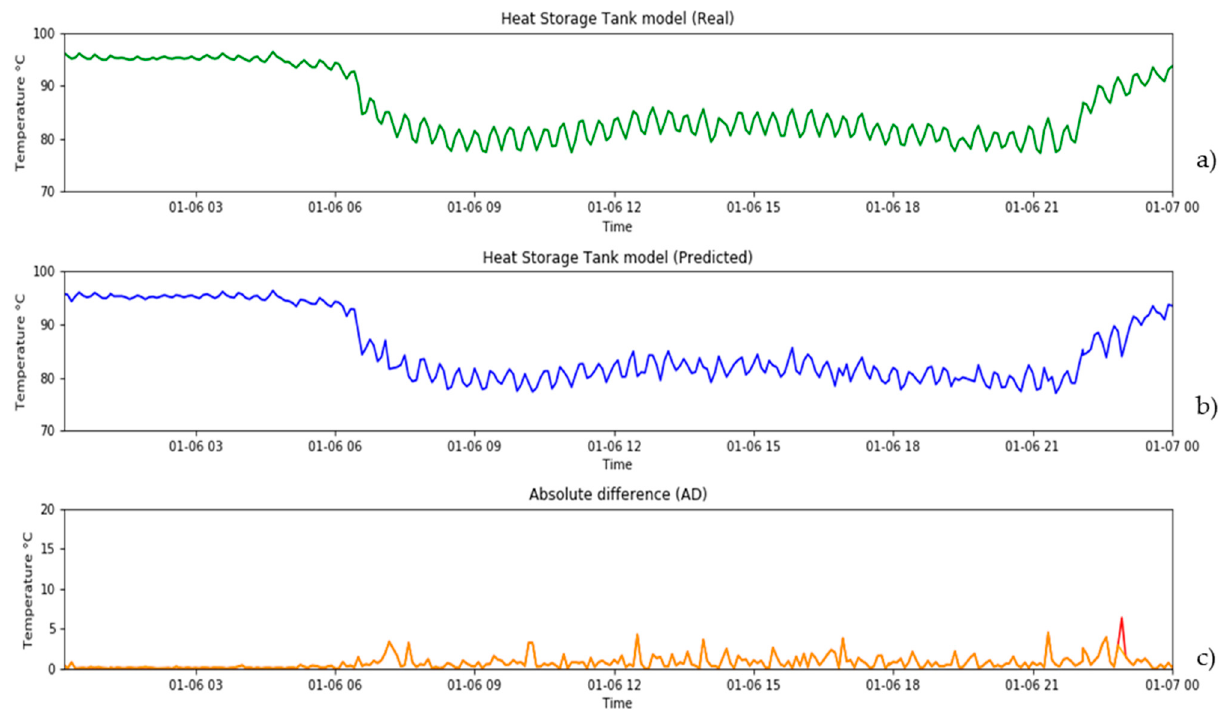
Figure 13. Real ( a ) vs. predicted ( b ) output of the individual heat storage model for the 6 January 2015, along with their absolute difference ( c ) (AD).